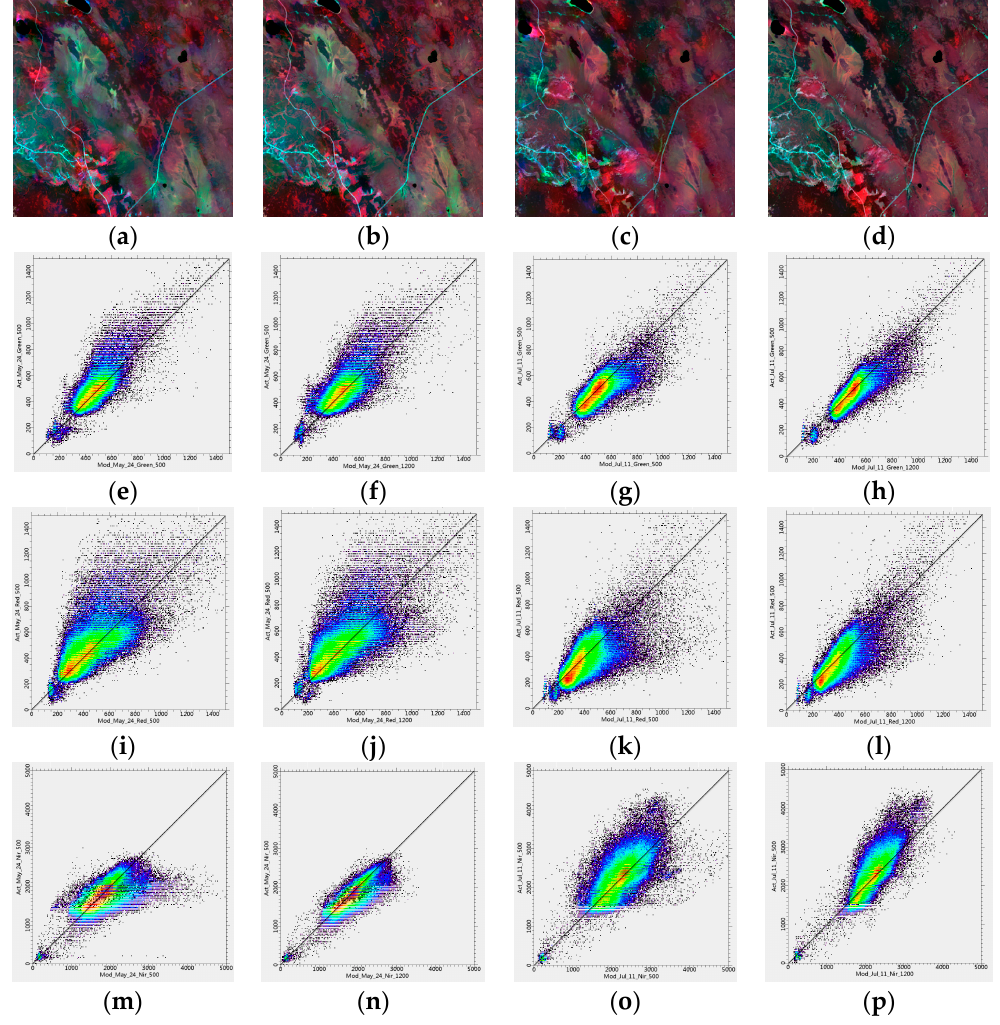
Figure 5. Proposed bi-directional fusion results with spatially extended training samples from the rural dataset: ( a – d ) the composited fusion results (NIR/red/green) modeled on 24 May and 11 July 2001 with training image sizes of 500 × 500 pixels and 1200 × 1200 pixels, respectively; and ( e – p ) comparisons among green, red, and NIR bands of the modeled reflectance and the actual reflectance that correspond to ( a – d ).